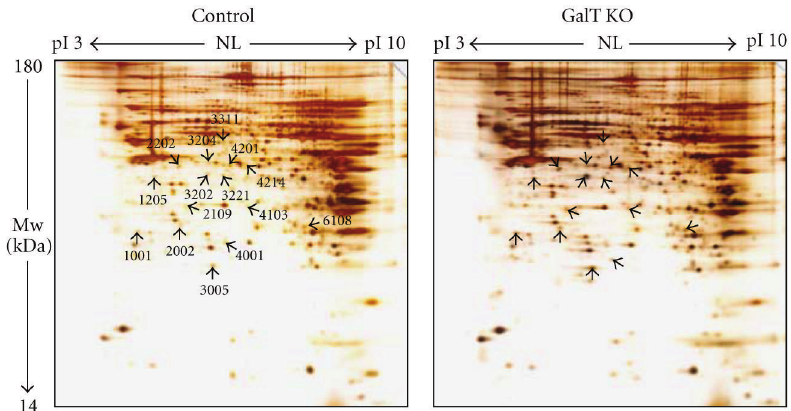
Figure 4: 2-D gel electrophoresis analysis of control and heterozygote GalT KO liver. Numbered spots were selected due to variations between the gels or overexpression in heterozygote GalT KO liver. Quantitative data were obtained from triplicate experiments. Identified spot numbers correspond to those in Table